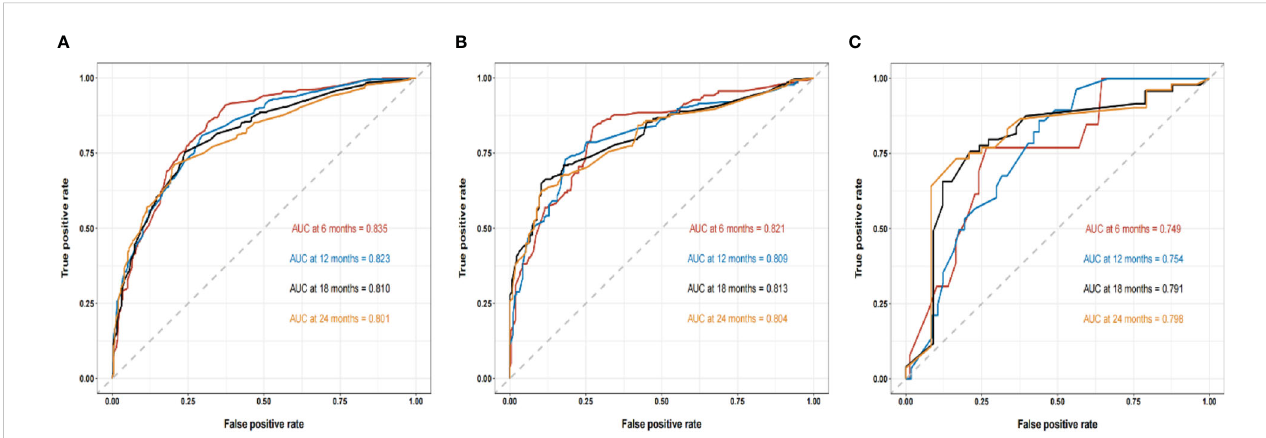
FIGURE 4 The ROC curves of the nomogram to predict 6-, 12-,18- and 24- months OS using the training cohort (A) , the internal validation cohort (B) , and the external cohort (C) , respectively.